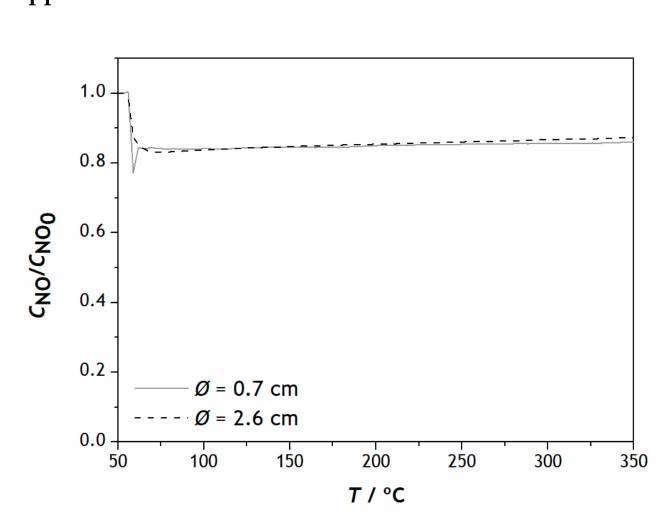
Figure A1. NO concentration in blank tests with [NO] = 1000 ppm in He with 5% of O 2 .